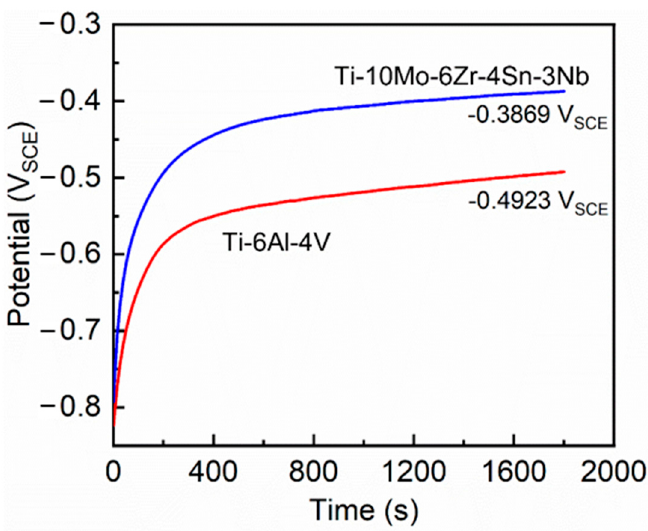
Figure 3. Open circuit potentials for Ti–10Mo–6Zr–4Sn–3Nb and